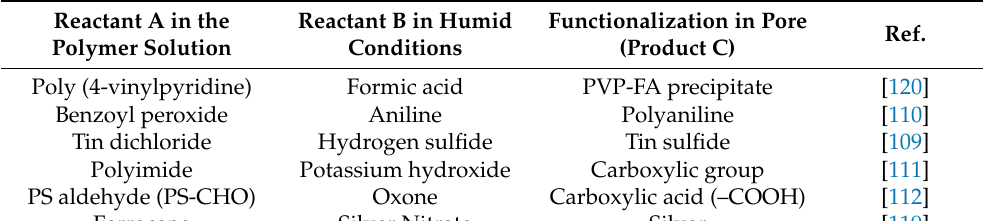
Table 3. Summary of reports using two reactants, one in the polymer solution and the other in a humid atmosphere for the functionalization of pores in HCP films.